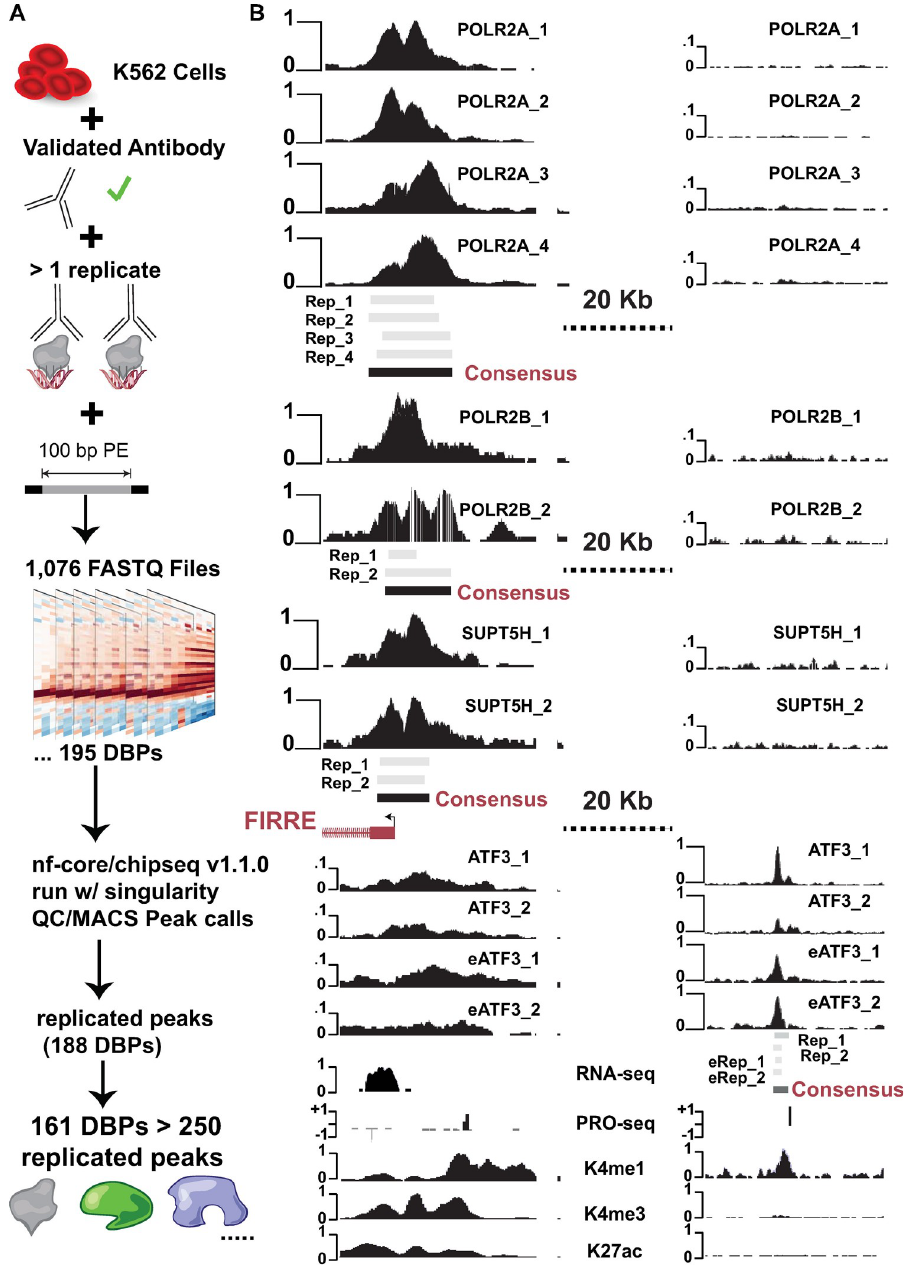
Fig 1. Framework of ChIP-seq analyses and peak calling across replicates. (A) Schematic of data quality requirements (validated antibody, two or more replicates, 100bp reads) resulting in 1,076 FASTQ files representing 195 unique DNA binding proteins. FASTQs were processed using the nf-core/chipseq pipeline (QC and peak calling). All FASTQ files passed nf-core quality control metrics. (B) Browser view of raw data, individual replicate peak calls and our consensus peaks. All scales are from 0 to 1 representing minimum and maximum reads in that window using UCSC auto-scale. Peaks from individual replicates are in gray and consensus peaks called are represented by black